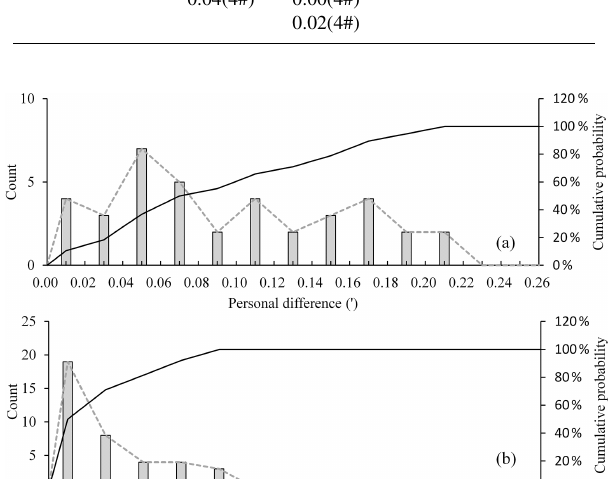
Figure 4. The declination and inclination baselines from Lanzhou Observatory. Table 4. The operator differences with respect to declination. The numbers in parentheses refer to the observation pillars in Fig. 1.